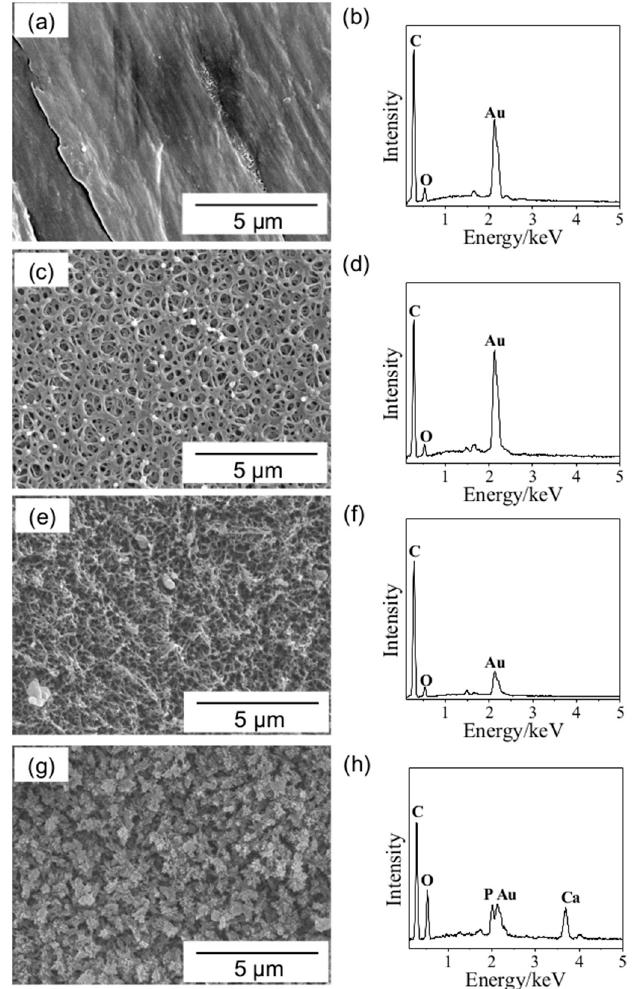
Figure 1. ( a , c , e , g ) SEM micrographs and ( b , d , f , h ) EDX profiles of the surfaces of ( a , b ) Sample N, ( c , d ) Sample S, ( e , f ) Sample SG, ( g , h ) Sample SGA.